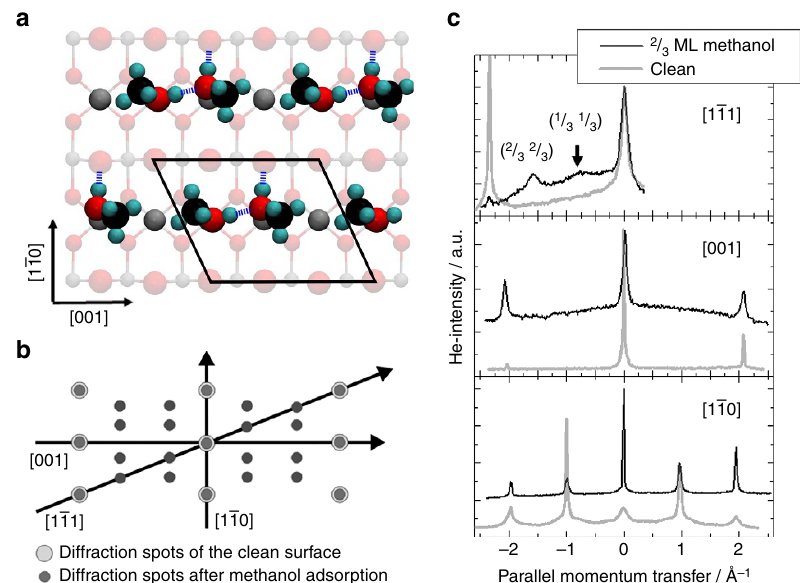
Figure 1 | Atomic structure of the methanol layer. ( a ) Energetically most favourable layer of intact methanol molecules at 2 / 3 ML surface coverage as obtained from the DFT calculations. Ti, O, C and H atoms are shown in grey, red, black and cyan. The L(1 (cid:2) 3) unit cell is indicated by solid lines. Consecutive [001]-rows are shifted by one lattice constant along [001] due to substrate-mediated repulsions between molecules along the ½ 1 (cid:2) 10 (cid:3) -direction. ( b ) Diffraction pattern of a L(1 (cid:2) 3) unit cell. ( c ) HAS angular distributions of the clean and methanol-covered surface reveal a L(1 (cid:2) 3) unit cell. Table 1 | Binding energies (in eV per molecule) for pairs of methanol molecules in different arrangements on the rutile TiO 2 (110) surface. Pairs along ½ 1 (cid:2) 10 (cid:3) 2/3 ML (1 (cid:2) 3)